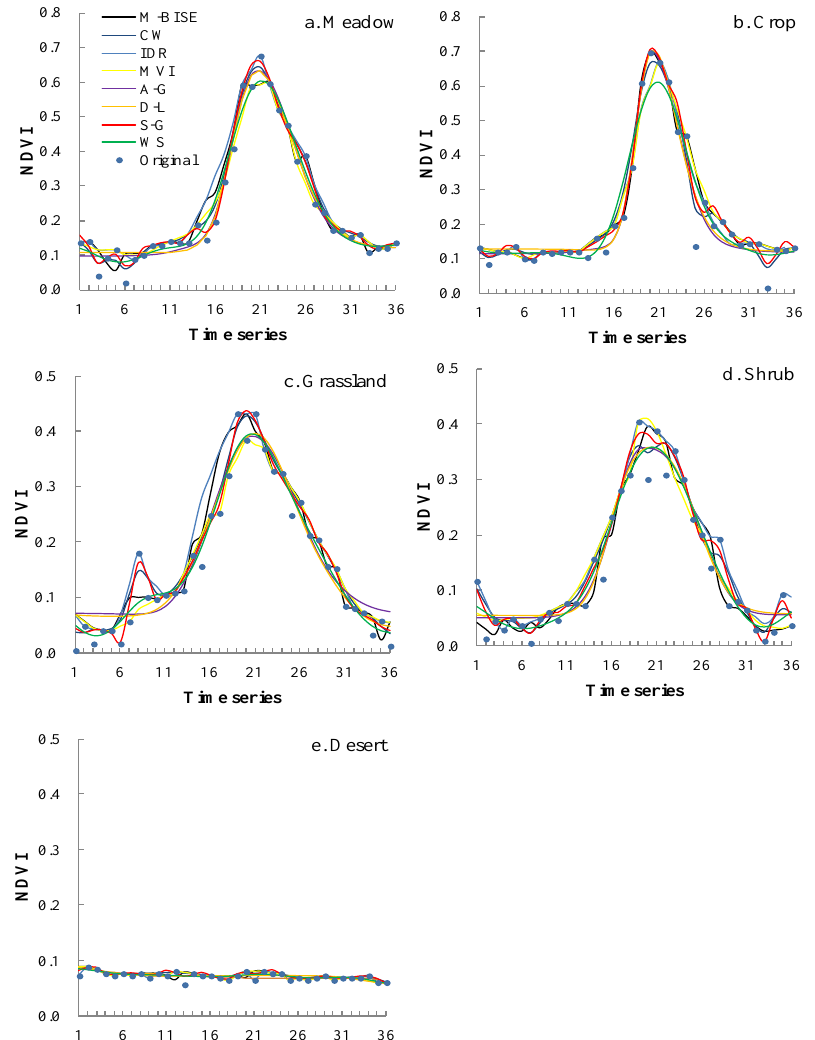
Figure 4. Eight techniques fitted to SPOT VGT NDVI time-series data acquired from homogeneous pixels of ( a ) meadow; ( b ) crop; ( c ) grassland; ( d ) shrub; and ( e ) desert